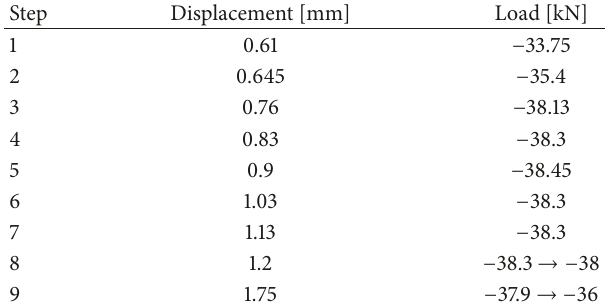
Table 5: Load conditions for the central